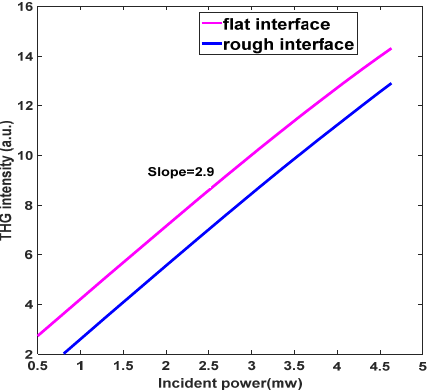
Figure 8. The function of pump power and THG power.